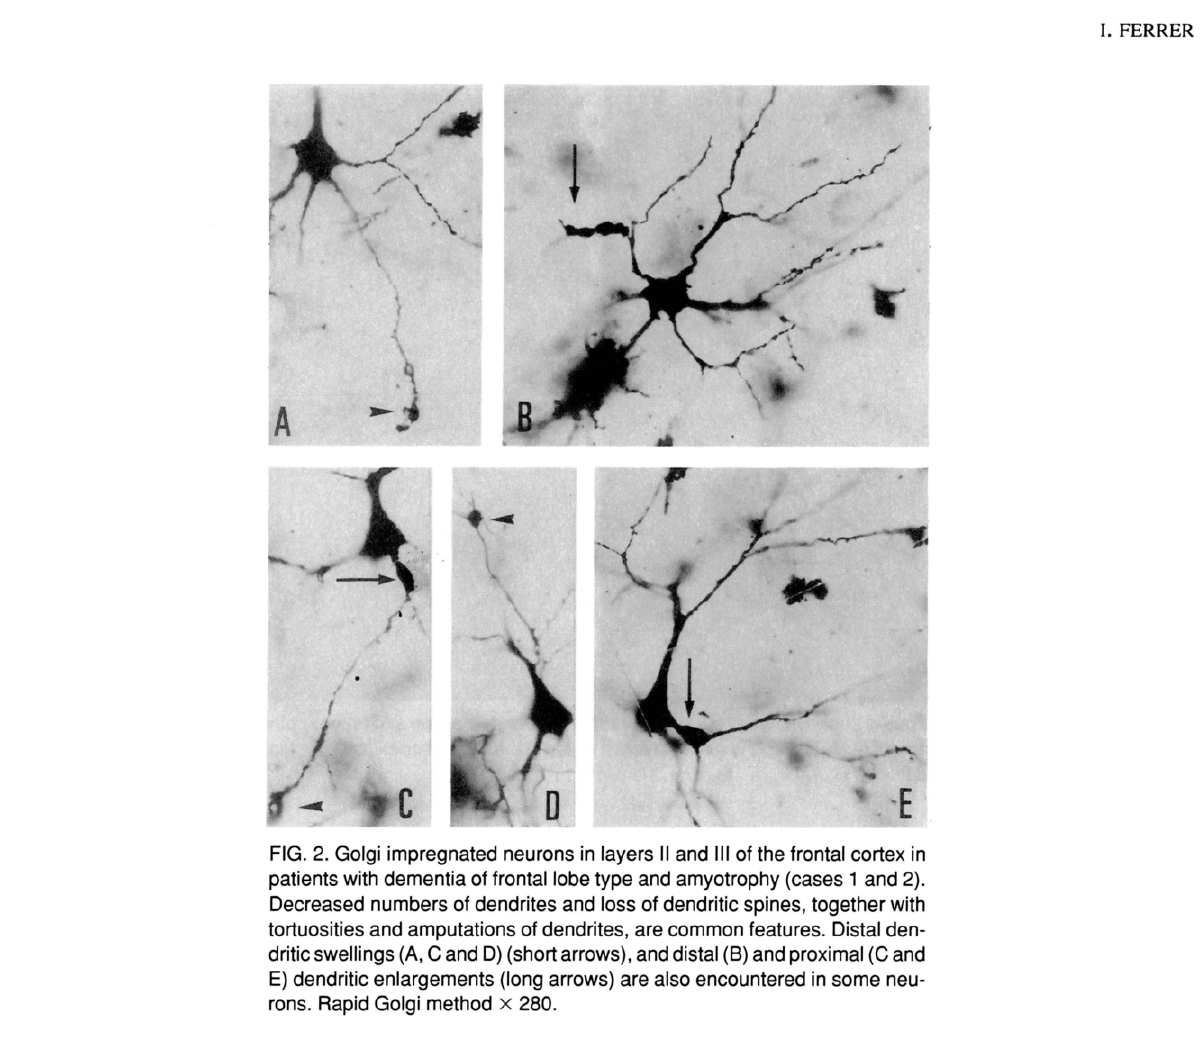
FIG. 2. Golgi impregnated neurons in layers II and III of the frontal cortex in patients with dementia of frontal lobe type and amyotrophy (cases 1 and 2). Decreased numbers of dendrites and loss of dendritic spines, together with tortuosities and amputations of dendrites, are common features. Distal den dritic swellings (A, C and D) (short arrows), and distal (8) and proximal (C and E) dendritic enlargements (long arrows) are also encountered in some neu rons. Rapid Golgi method x